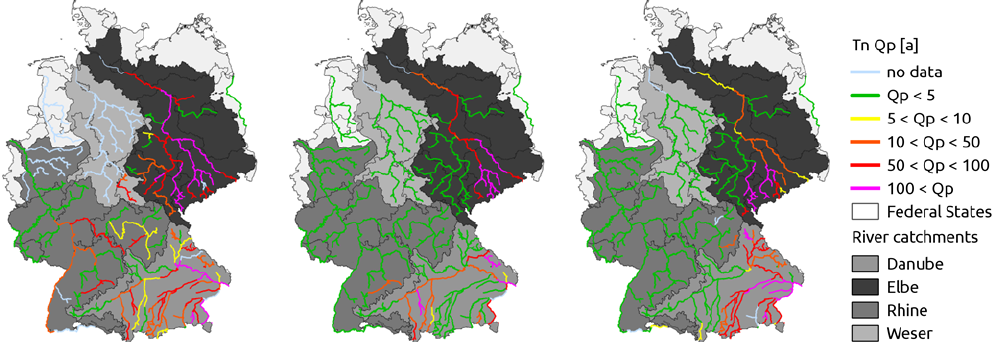
Figure 11. Regionalized return periods (Tn) of flood peak discharges for June 2013 (left), August 2002 (middle) and July 1954 (right). Gauge data were made available by the Water and Shipping Management of the Fed. Rep. (WSV) prepared by the Federal Institute for Hydrology (BfG) and environmental state offices of the federal